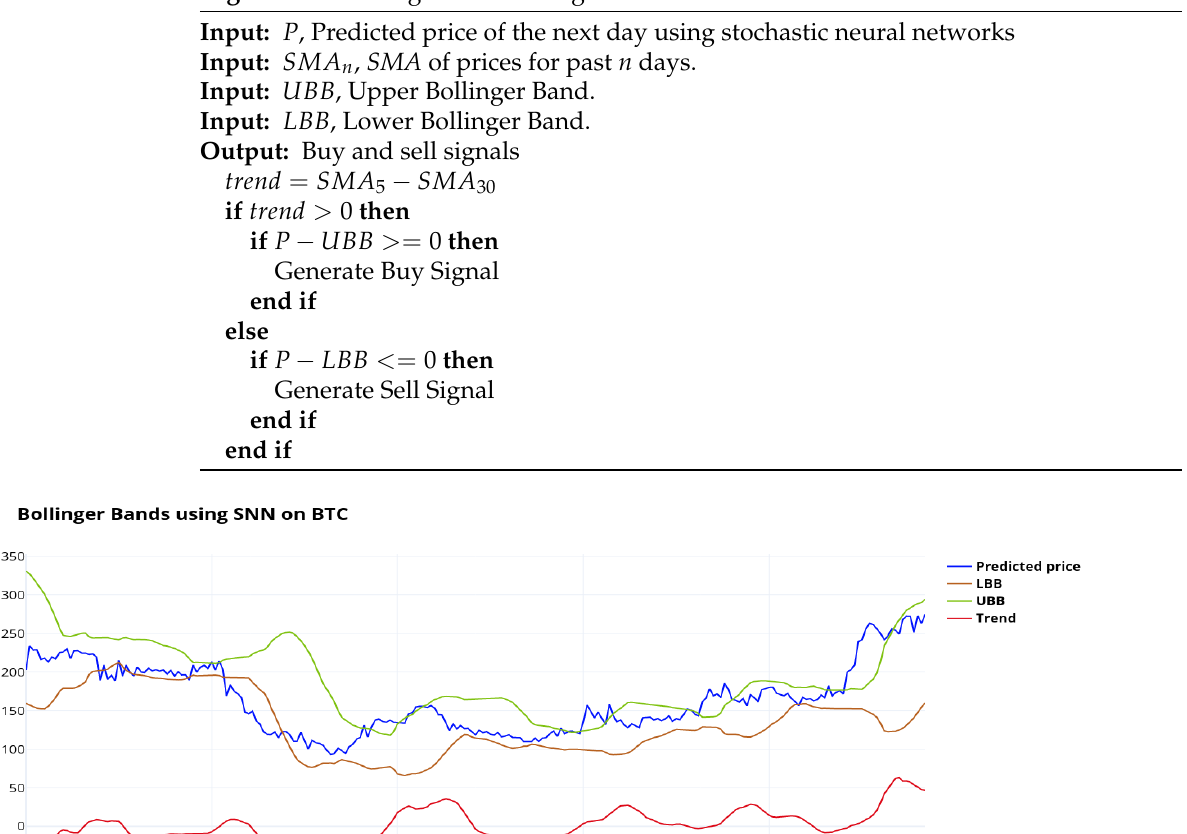
Algorithm 2 Bollinger Bands using stochastic neural networks.